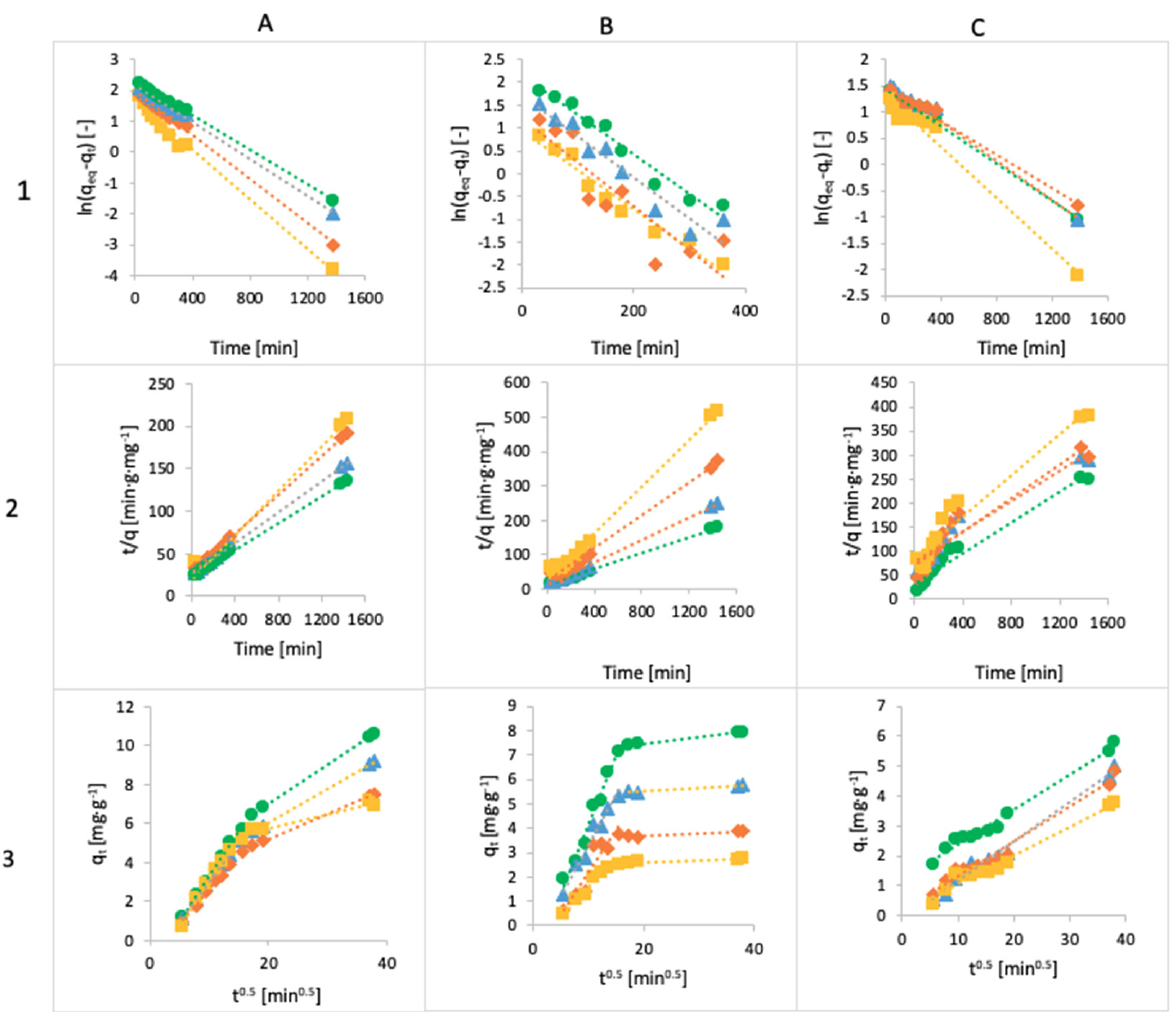
Figure 12. The linearized integral form of the pseudo-first-order Lagergren equation of methylene blue ( A1 ), famotidine ( B1 ) and diclofenac ( C1 ), linearized integral form of the pseudo-second-order model of methylene blue ( A2 ), famotidine ( B2 ) and diclofenac ( C2 ) and intraparticle diffusion model of methylene blue ( A3 ), famotidine ( B3 ) and diclofenac ( C3 ) using Ca-Alg2 ( ◼ ), Ca-Alg2/GO5 ( ♦ ), Ca-Alg2/GO10 ( ▲ ) and Ca-Alg2/GO20 ( ● ) beads. (See Supplementary materials for the full-size plots.).